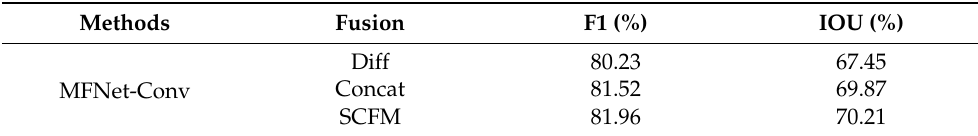
Table 6. Results of ablation experiments with different fusion methods of change features on the SYSU-CD dataset.